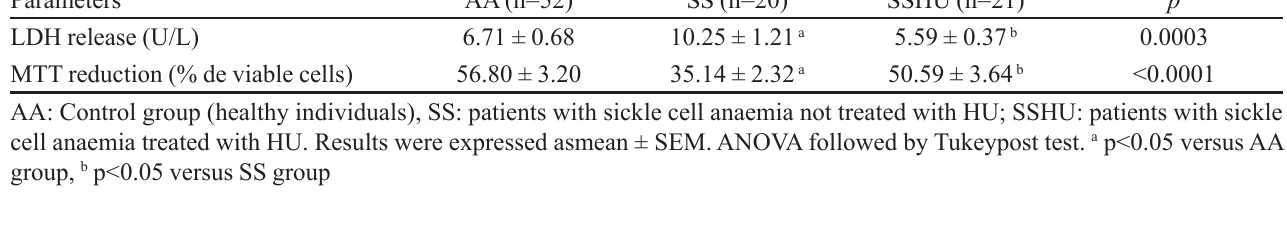
TABLE III - Influence of treatment with HU in the parameters of cytotoxicity in neutrophils from patients with sickle cell anaemia Parameters